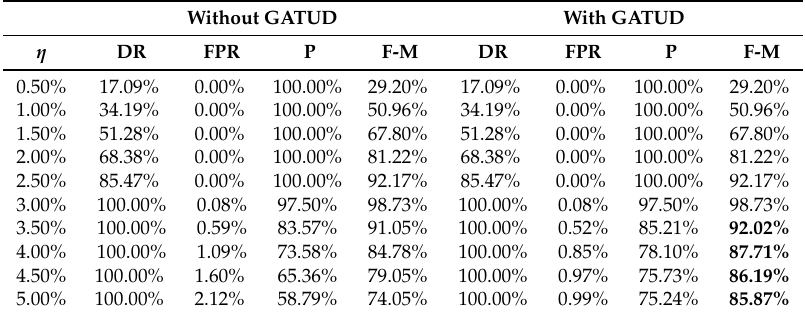
Table 5. The separation accuracy of abnormal observations with/without GATUD on SIRD. Without GATUD With GATUD